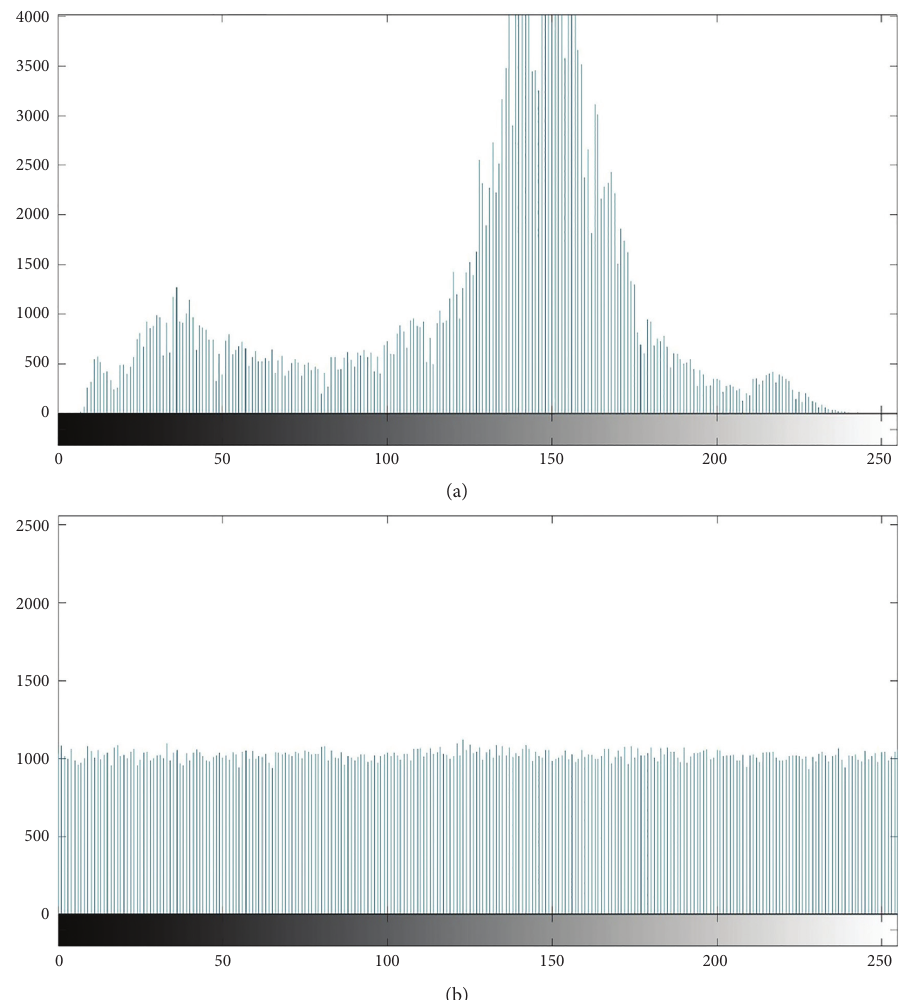
Figure 9: Histogram distribution analysis of plain and encrypted grayscale image. (a) Plain grayscale “Boat” image; (b) encrypted grayscale “Boat”